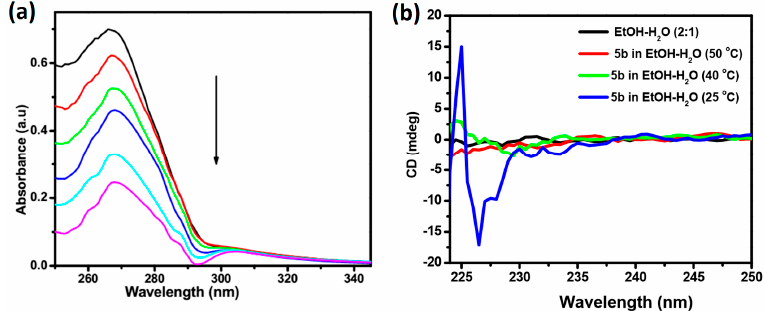
Figure 3. ( a ) UV-VIS titration of gelator 5b dissolved in ethanol (1 × 10 − 5 M) with water. In the titration experiment, the direction of the arrow shows the response of absorbance/wavelength with the piecemeal addition of 100 µ L of water. Two milliliters of the initial volume of solution (1 × 10 − 5 M) was taken for titration experiments; and ( b ) CD spectra of gelator 5b at variable temperature (1 × 10 − 5